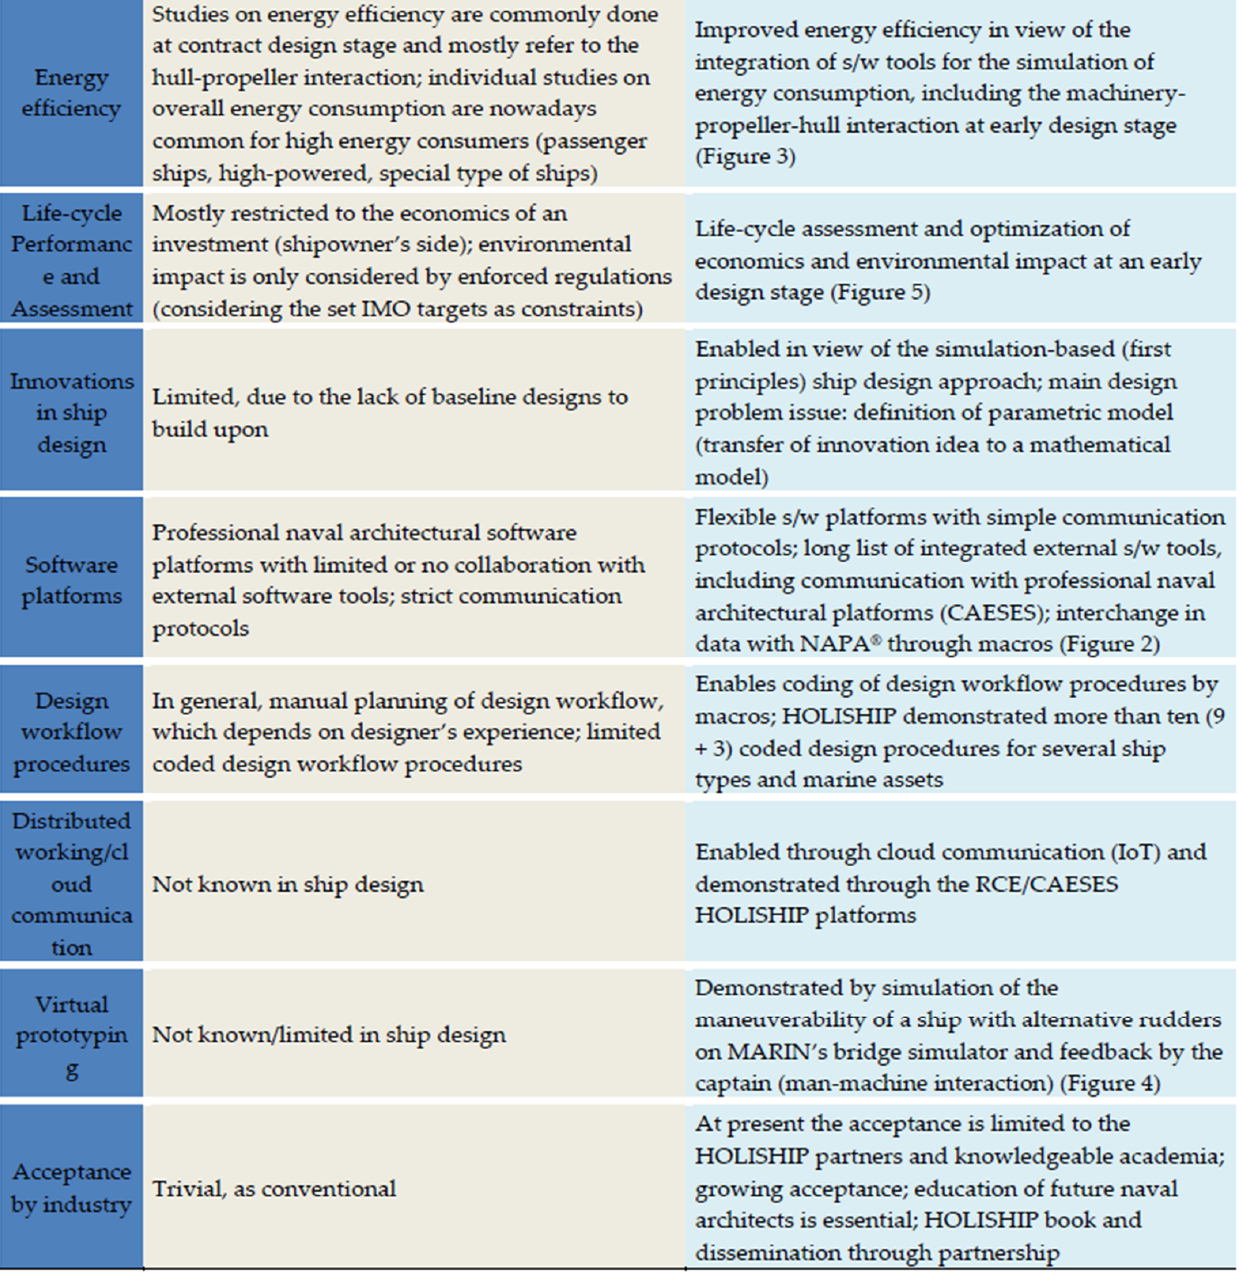
Figure 14. Conventional vs. HOLISHIP Approach to Ship